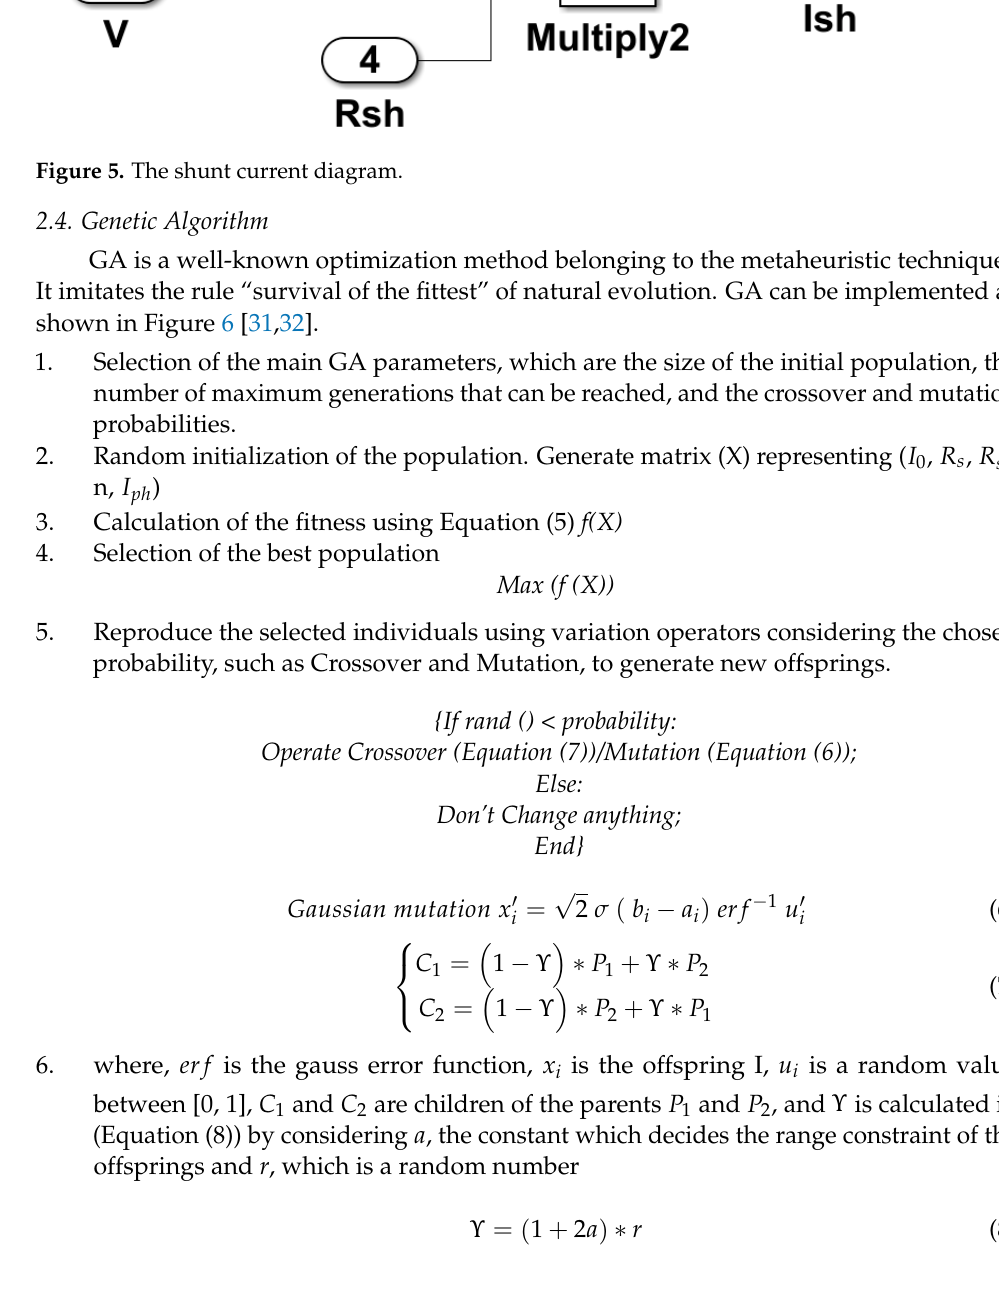
Figure 6. Genetic algorithm flow chart. 2.5. Particle Swarm Optimization